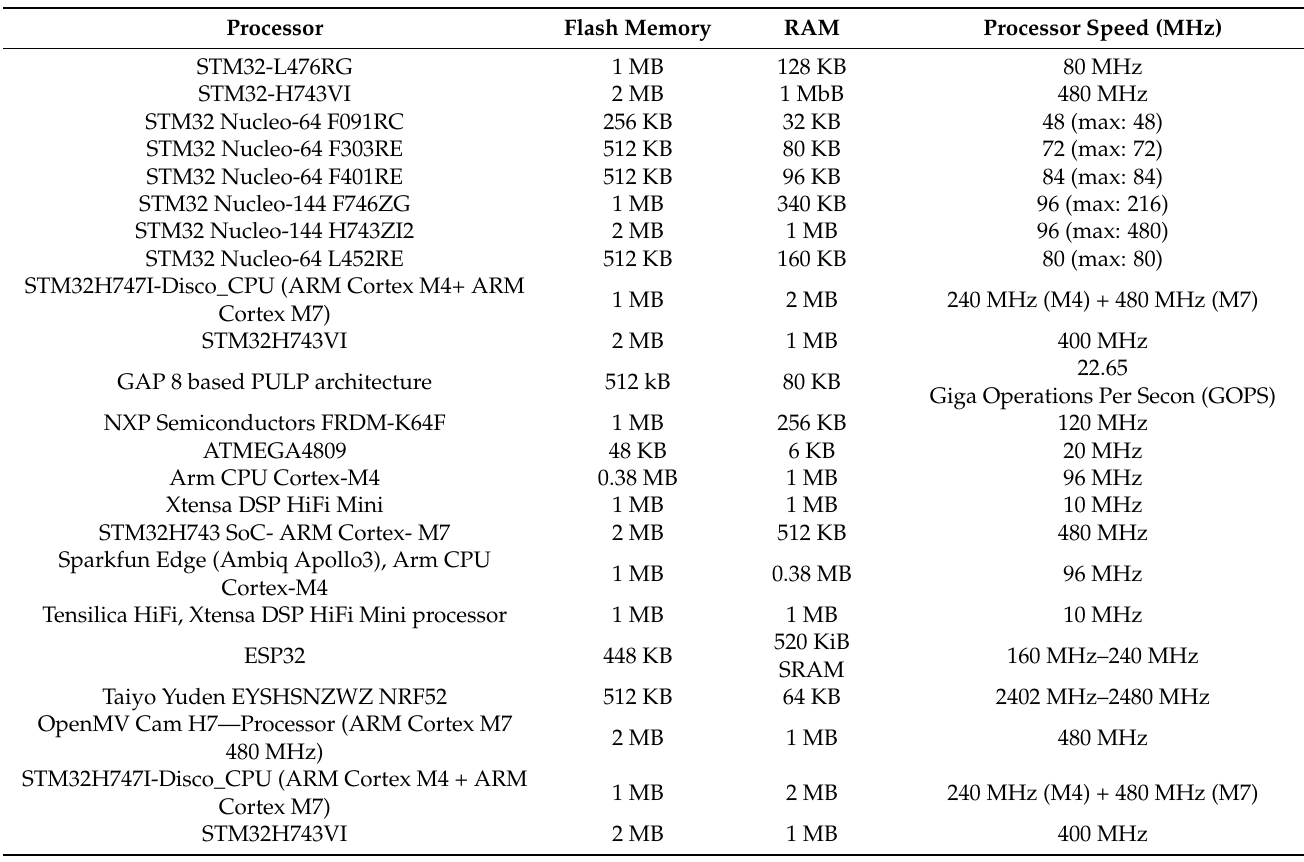
Figure 6. TinyML devices distribution in previous studies. Table 6. Summary of TinyML devices used in different previous studies.